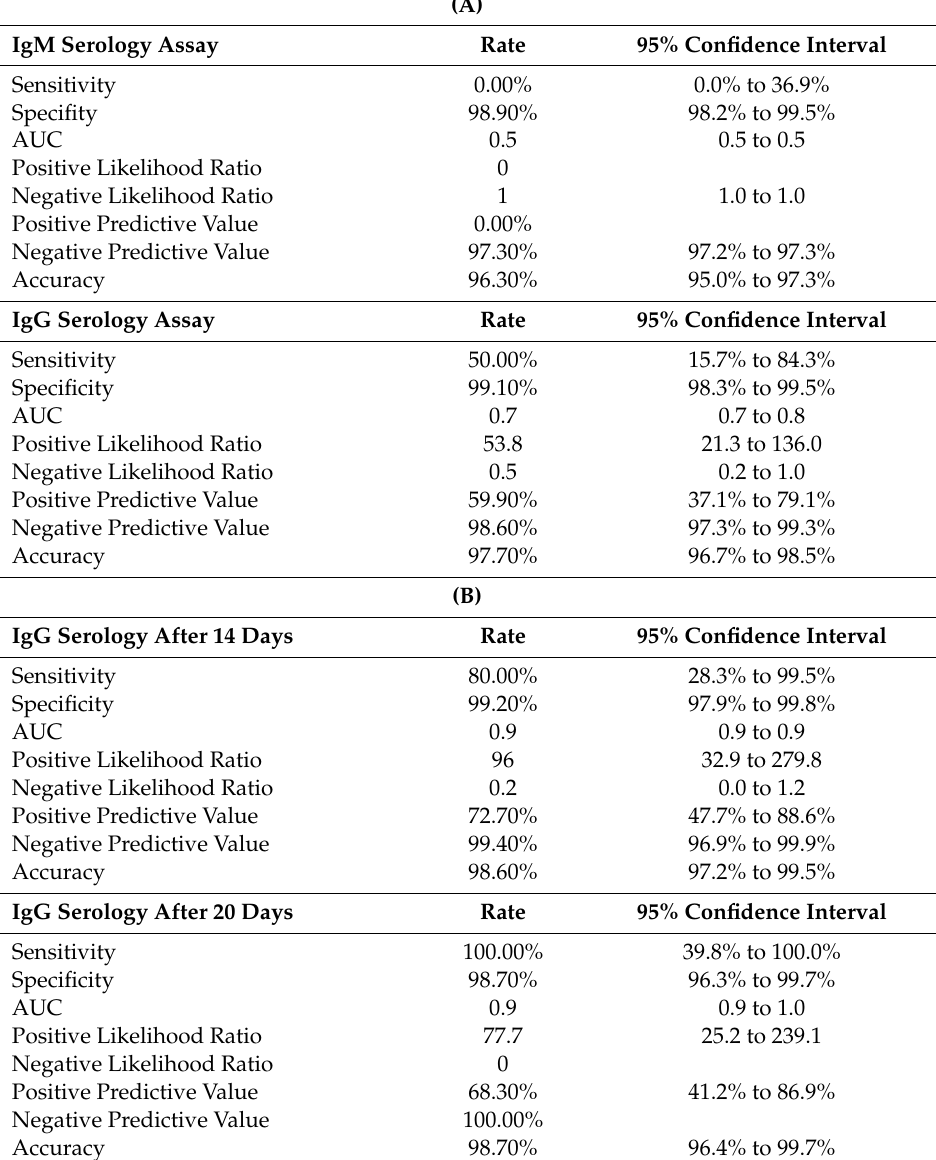
Table 3. ( A ) Diagnostic performance of SARS-CoV-2 IgM and IgG serology (index test) in comparison with RT-PCR (reference standard) irrespective of the time interval between swabs and serology. ( B ) Diagnostic performance of SARS-CoV-2 IgG serology (index test) in comparison with RT-PCR (reference standard) considering a time interval of at least 14 days and 20 days between swabs and